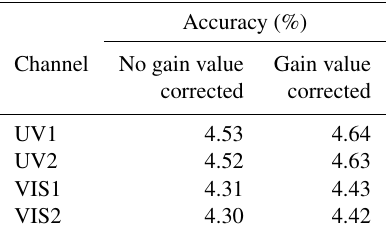
sponse coefficient σ α is obtained for the irradiance cali- 0 ,β 0 bration model of the EMI.